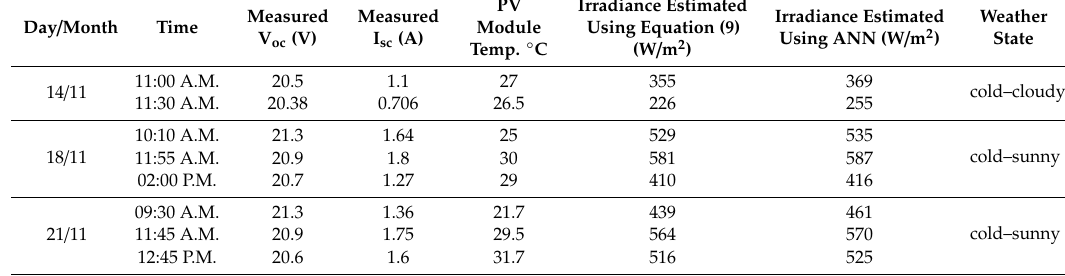
Figure 8. Experimental setup.